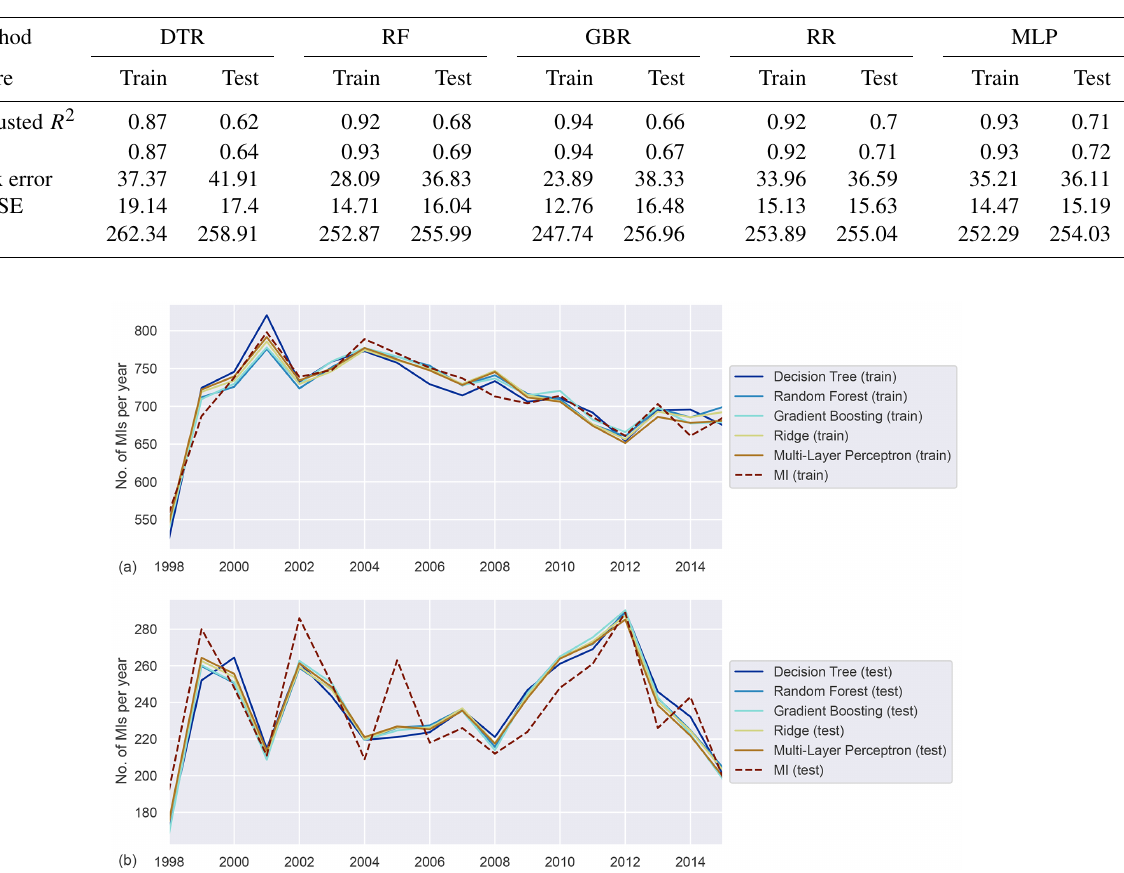
Figure 4. Annually aggregated predictions of MI in the general population for all models. Predicted (solid) and observed MI (dashed) for training (a) and test (b)